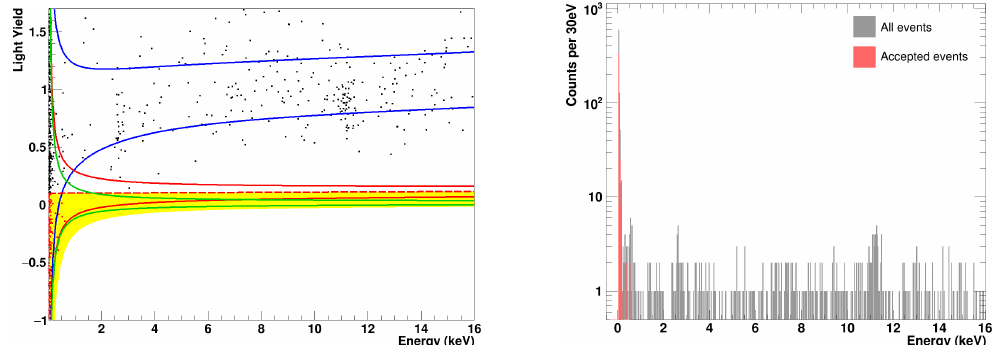
Figure 40: Left: Schematic of the CRESST-III detectors highlighting aspects of the improved detector design which includes fully scintillating housing and CaWO strumented holding sticks. Right: Picture of a CRESST-III detector module. Adapted from [ 66 ] .